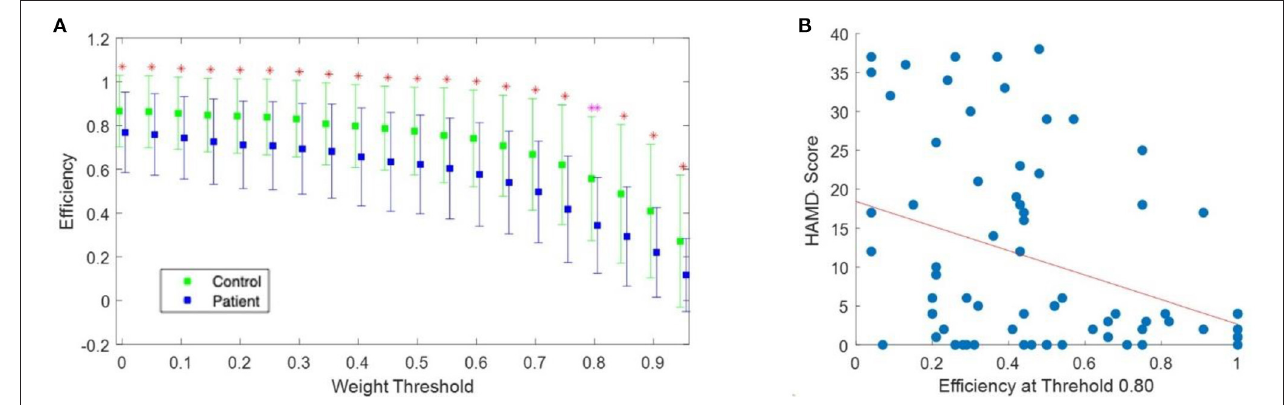
FIGURE 5 | (A) Efficiency as a function of the threshold value. The green squares indicate efficiency in the control group while the blue squares indicate efficiency in the patient group. The error bar indicates the standard deviation. The magenta double asterisk indicates a significant difference at the level of 0.001, while red asterisks indicate a significant difference at the level of 0.05 ( p -values were FDR-corrected). (B) Scatter plot of the efficiency at a threshold of 0.80 vs HAMD scores. The red line indicates the least-squares line. FDR, false discovery rate; HAMD, hamilton depression rating